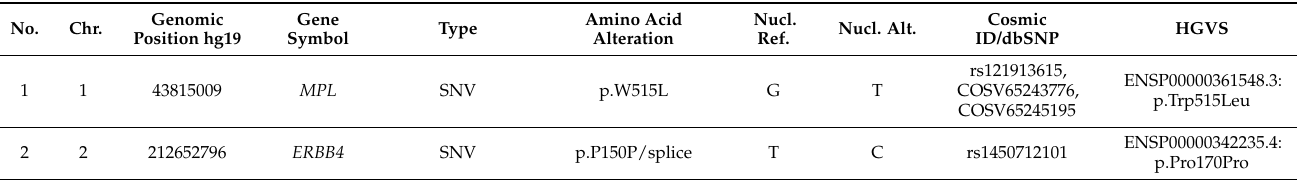
Table 2. Identified somatic variants in a metastatic melanoma